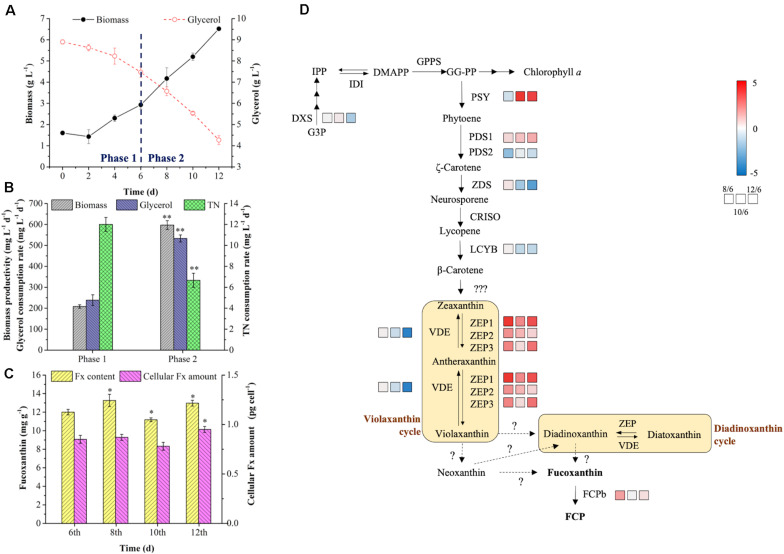
Bioprocess analysis of R: B (5:1) + T group in the batch 2. Production and nutrient consumption (A,B) in two-phase culture, fucoxanthin content and intercellular amount (C), genes expression levels in fucoxanthin biosynthesis pathway on the 6th, 8th, 10th, 12th days in phase 2 (D). Significant differentiation level was set with * p < 0.05 and ** p < 0.01 compared with that at 6th day in phase 1, respectively. The color boxes indicate the expression values of log2FC (8th/6th), log2FC (10th/6th), and log2FC (12th/6th).